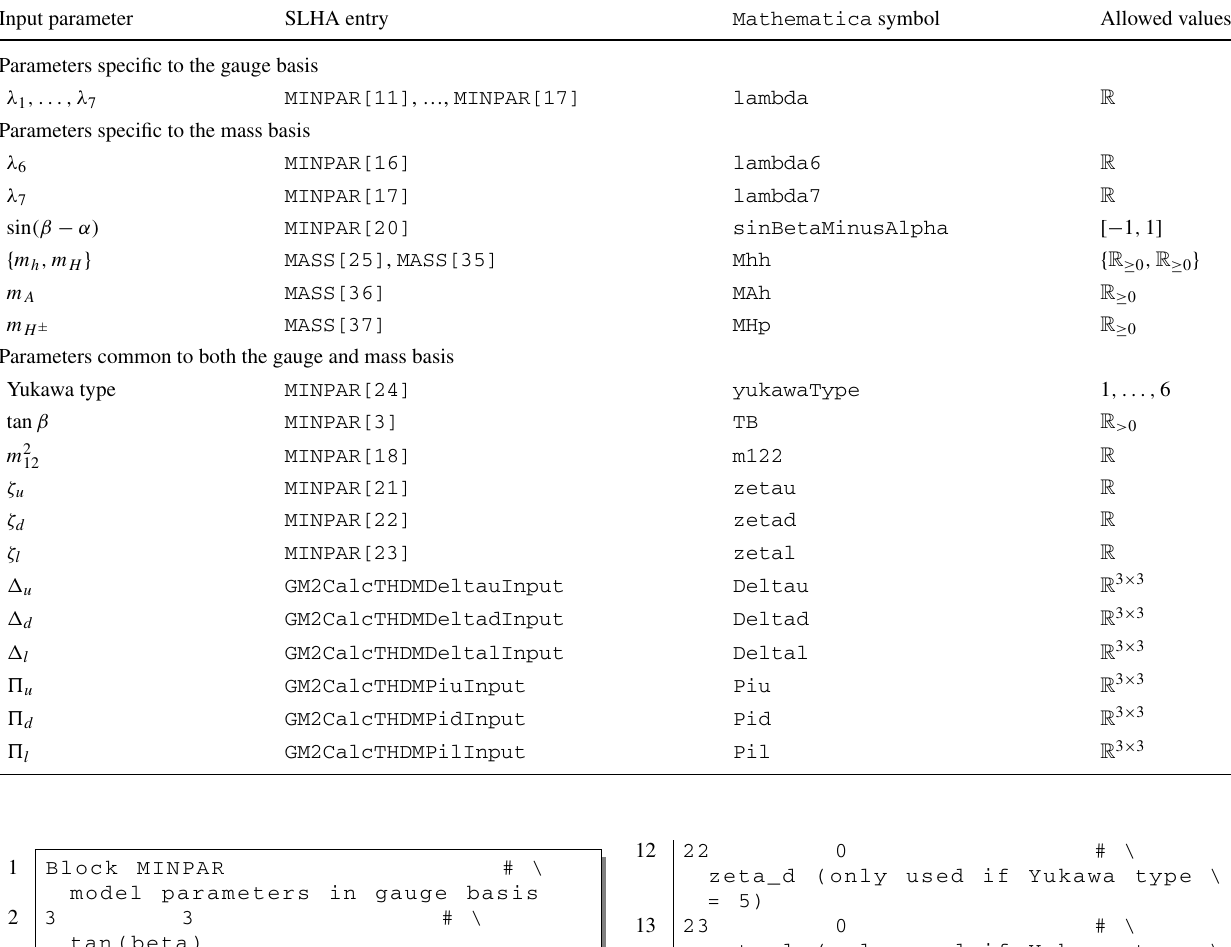
Table 3 2HDM input parameters for the SLHA and Mathematica interface Input parameter SLHA entry Mathematica symbol Allowed